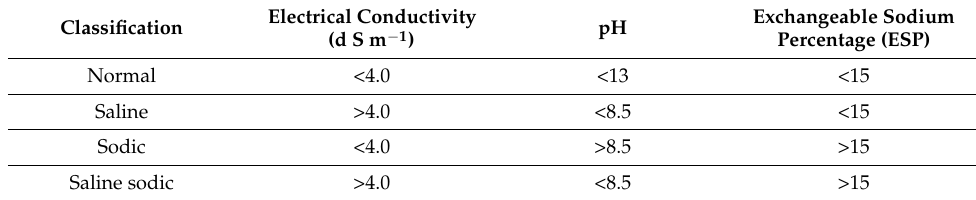
Table 2. Classification of soil based on soil pH, EC, and ESP. Bastida et al. [39].